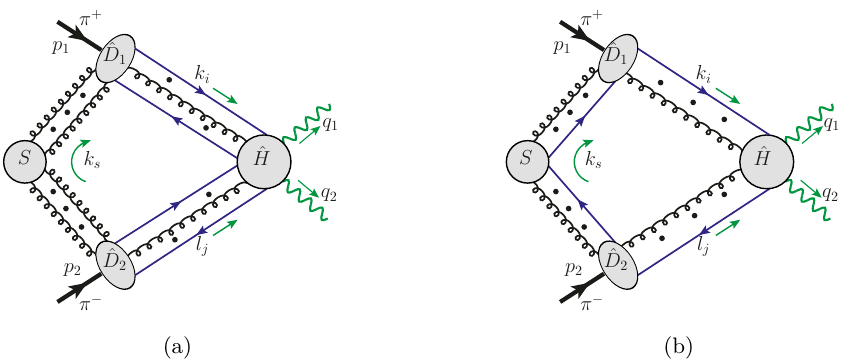
Figure 6. Two possible leading regions for the exclusive π + π − annihilation to two photons. An arbitrary number of longitudinally polarized gluons can connect the collinear subgraph ˆ D 1 or ˆ D 2 to ˆ H or S